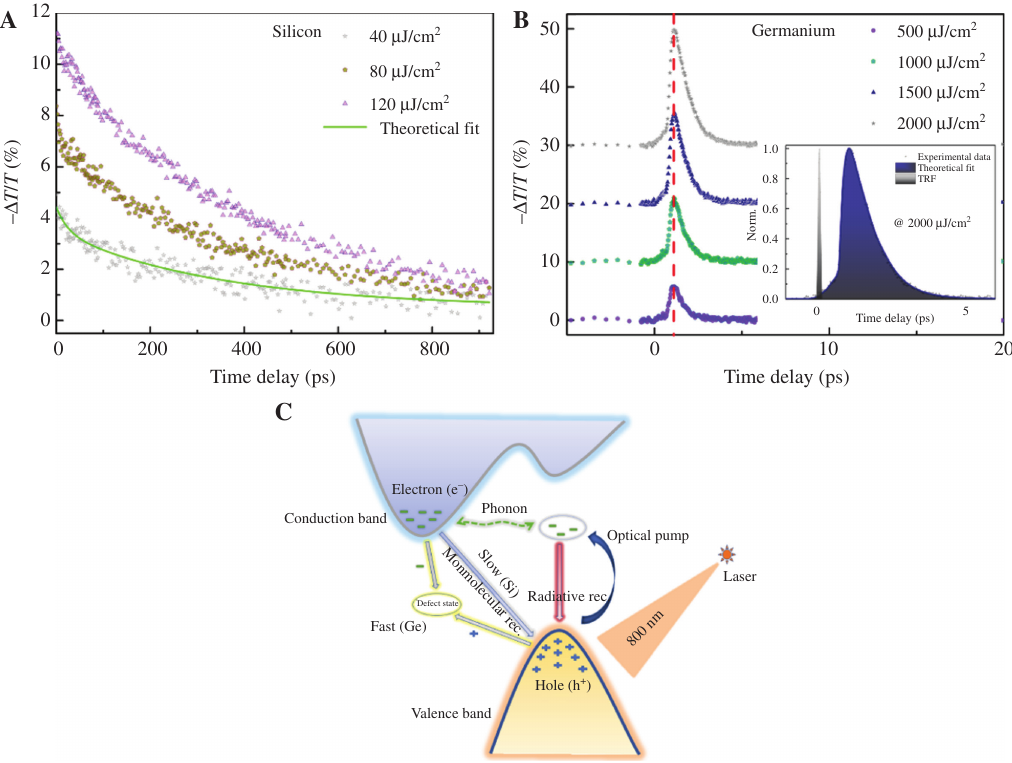
Figure 5: Measured transient negative differential transmission −∆ T / T for Si and Ge thin films implemented by using OPTP measurements for various pump fluences. The solid curves represent the fittings of recombination processes by utilizing rate equations, whereas the dotted lines are measured by experiment. (A) Normalized and time-resolved THz transmission curve of Si film under the pump fluences of 40, 80, and 120 μ J/m 2 . (B) Normalized and time-resolved THz transmission curve of Ge film under the pump fluences of 500, 1000, 1500, and 2000 μ J/m 2 . Plots are shown with vertically offset for clarity. The inset presents the fit result and corresponding instrument response function. (C) Diagrammatic sketch of photoexcited carrier transitions in Si and Ge